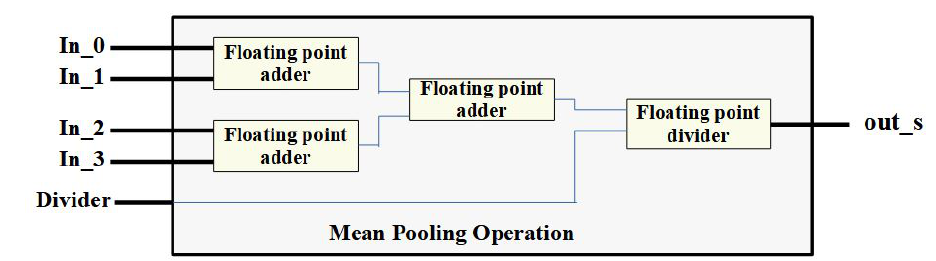
Figure 11. Visual representation of the mean pooling using FP adders and